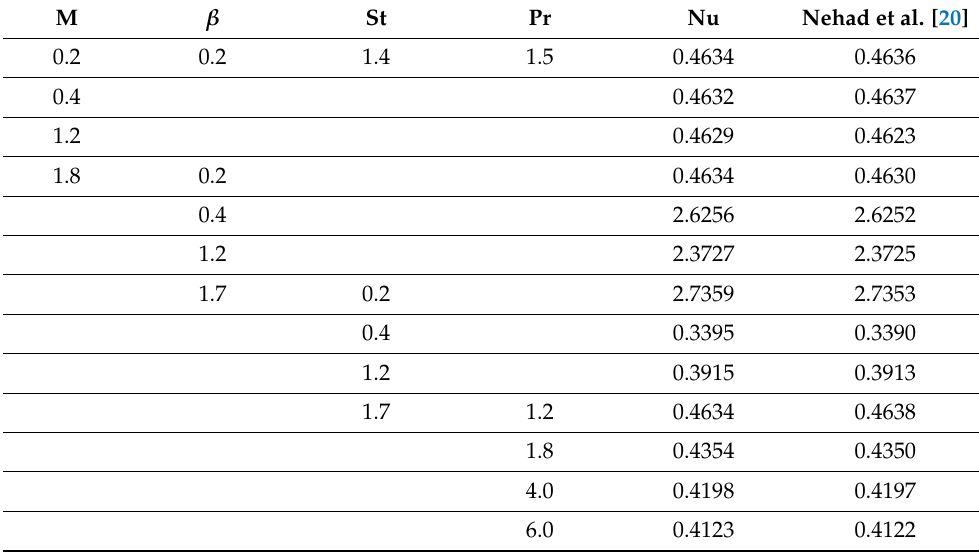
Table 3. Influence of Pr, M, Rd, and St on Nusselt number and its